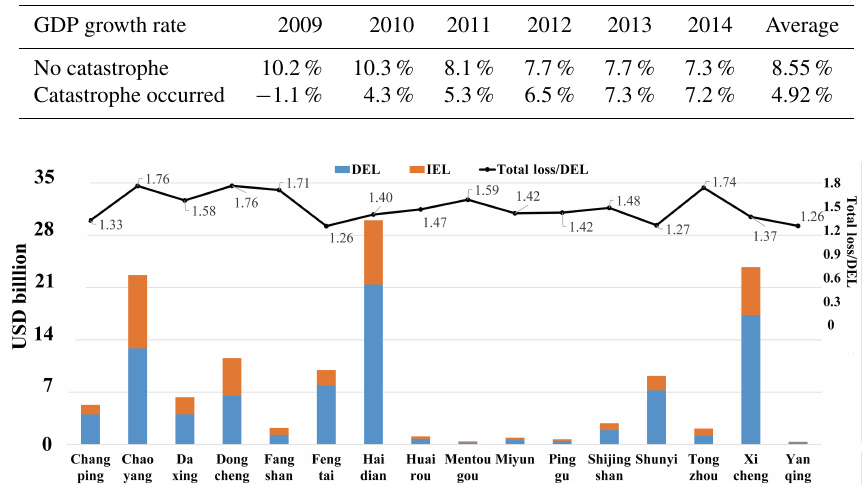
Table 4. The comparison of the GDP growth rate between no catastrophe and the assessment result under scenario A 6 years after the catastrophe occurred.